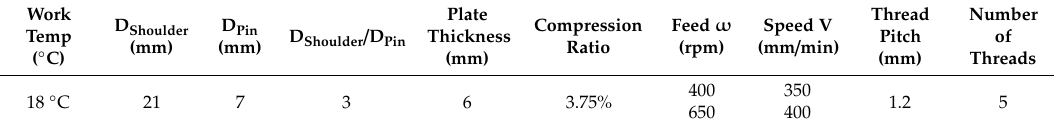
Table 2. Parameters of the BFSW process for the AA6082-T6 weld